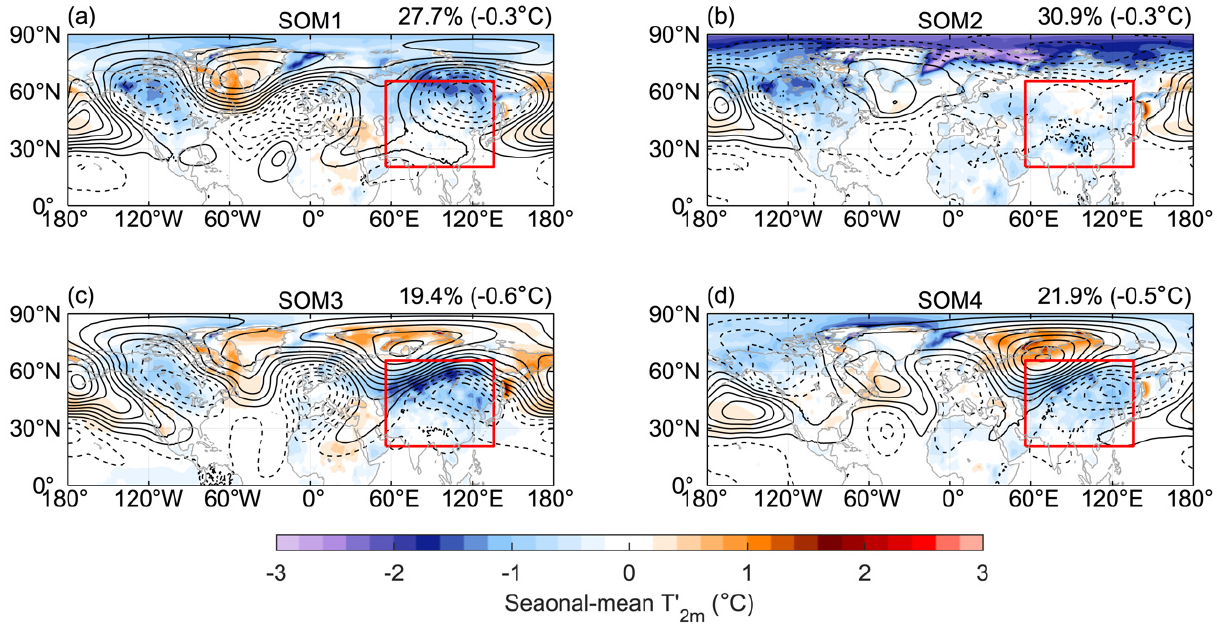
Figure 5. Composites of the background circulation and temperature anomalies for the four SOM groups: ( a ) SOM1, ( b ) SOM2, ( c ) SOM3, ( d ) SOM4. The contour in each plot is winter-mean anomalous Z500 with a contour interval of 4 m. The shaded area is the winter-mean anomalous T 2m over 95% confidence level.